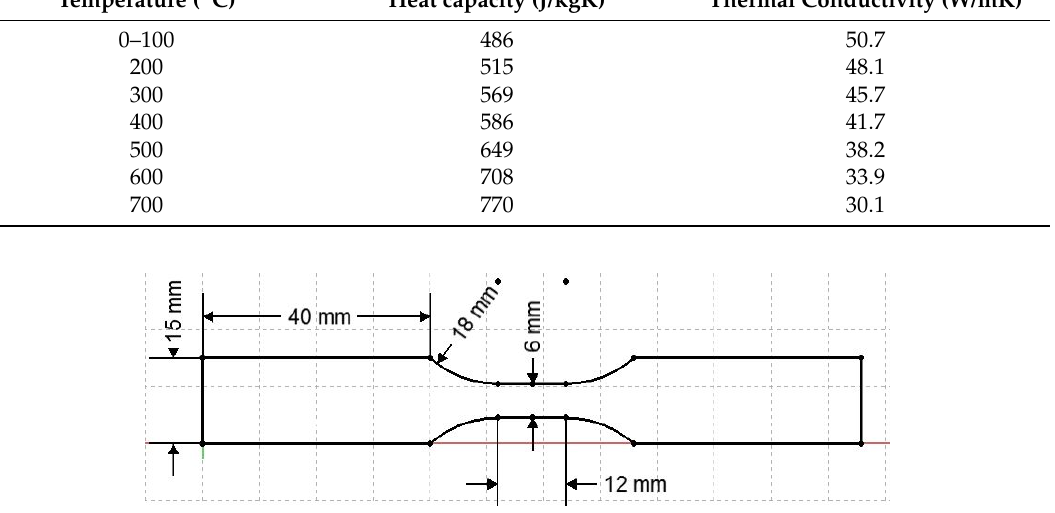
Figure 1. Specimen geometry.